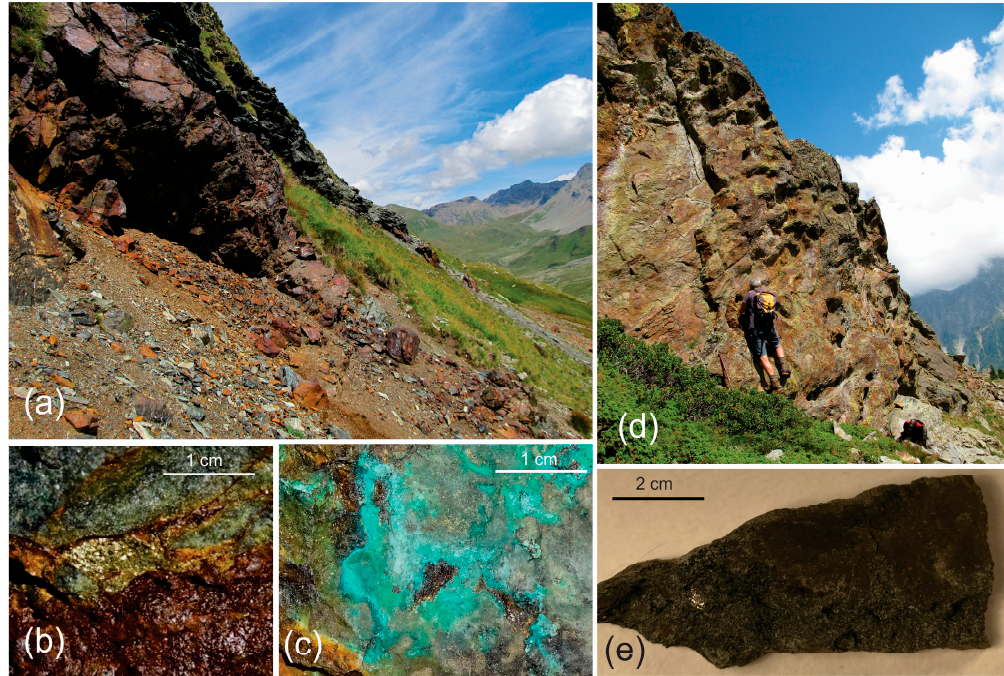
Figure 17. Images of ore deposits. ( a – c ) Alp Tavretga; ( a ) outcrop with red ore concentration; ( b ) hand specimen with chalcopyrite and magnetite; ( c ) copper ore altered to malachite. ( d , e ) Val Perossa; ( d ) outcrop with ore-rich layers; ( e ) hand specimen with pyrite in